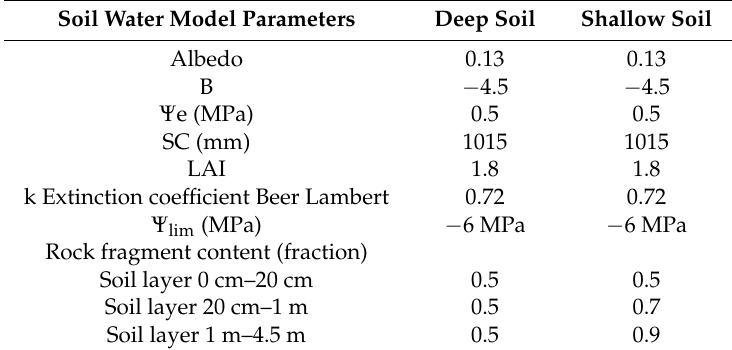
Table A1. List of parameters used in the water model under the hypothesis of a deep soil and a shallow soil.